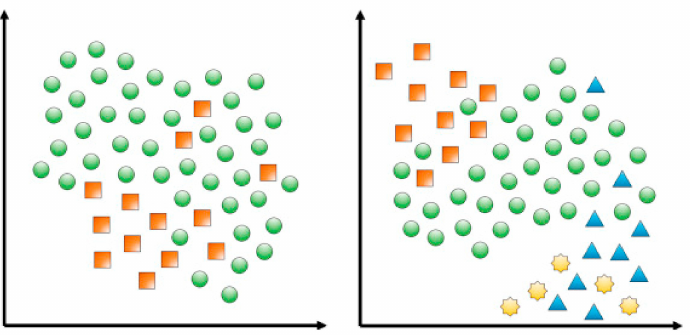
Figure 1. Two possible class imbalance scenarios: ( left ) binary imbalanced problem and ( right ) multi-class imbalanced problem